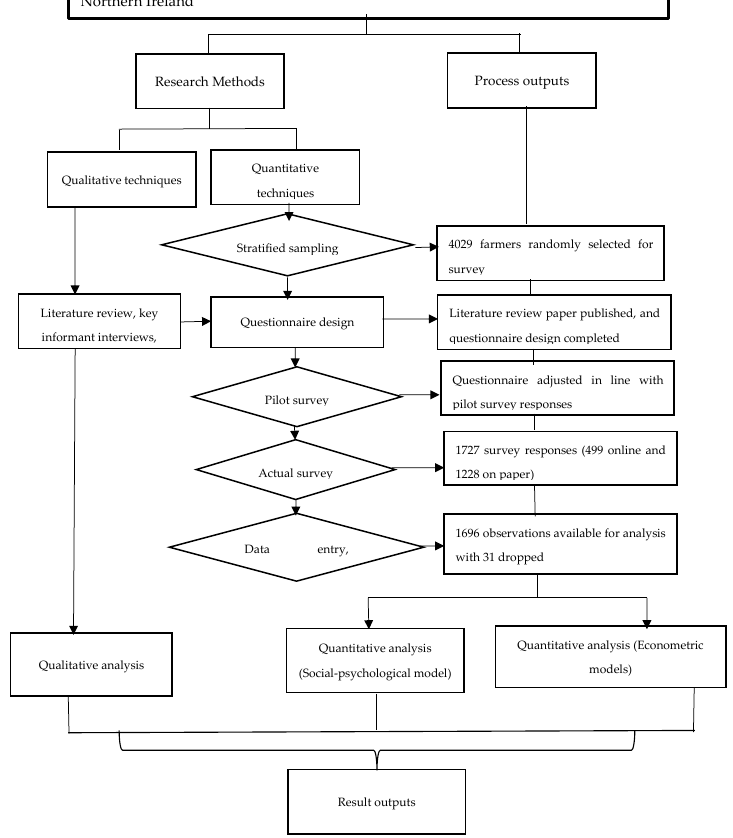
Figure 1. Flow chart of study’s research components and